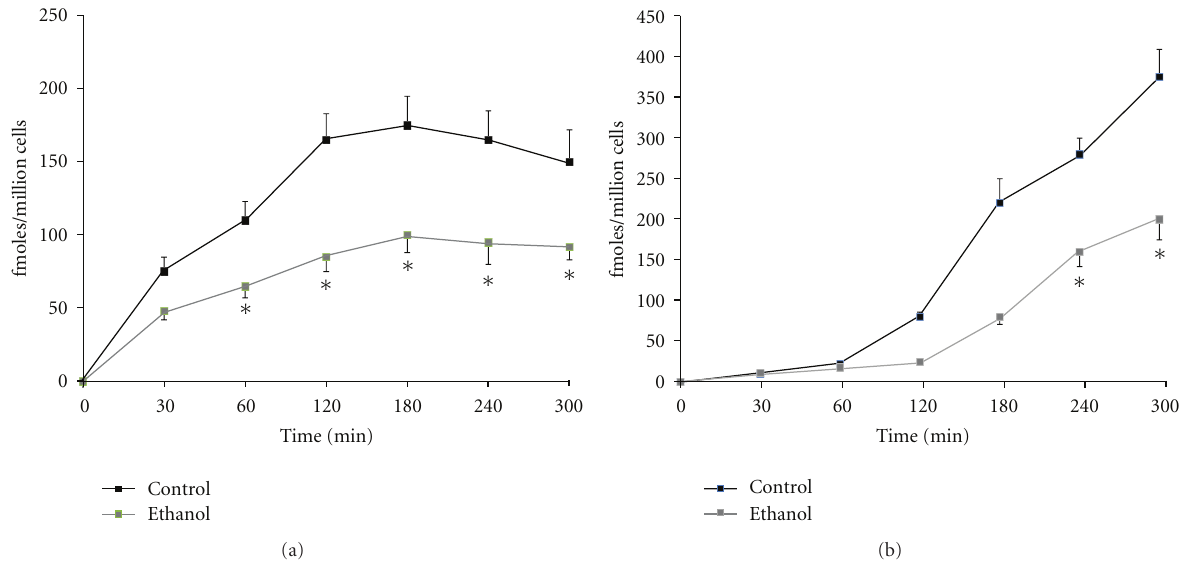
Figure 3: E ff ects of cyanamide on kinetics of internalization (a) and degradation (b) of 125 I-ASOR in HAD cell cultures grown in the presence ( (cid:2) ) or absence ( (cid:3)(cid:2) ) of 25 mM ethanol. Internalization (a) and degradation (b) of ASOR were determined as described in Figure 3. Data are presented as fmoles ASOR degraded or internalized per million cells and are means ± SEM for 4-5 separate experiments. Values significantly di ff erent from controls are indicated, ∗ P < 0 .